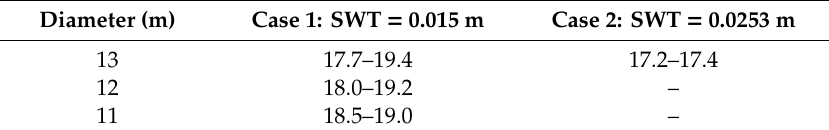
Table 6. Design result for concrete ballast height from step 1.